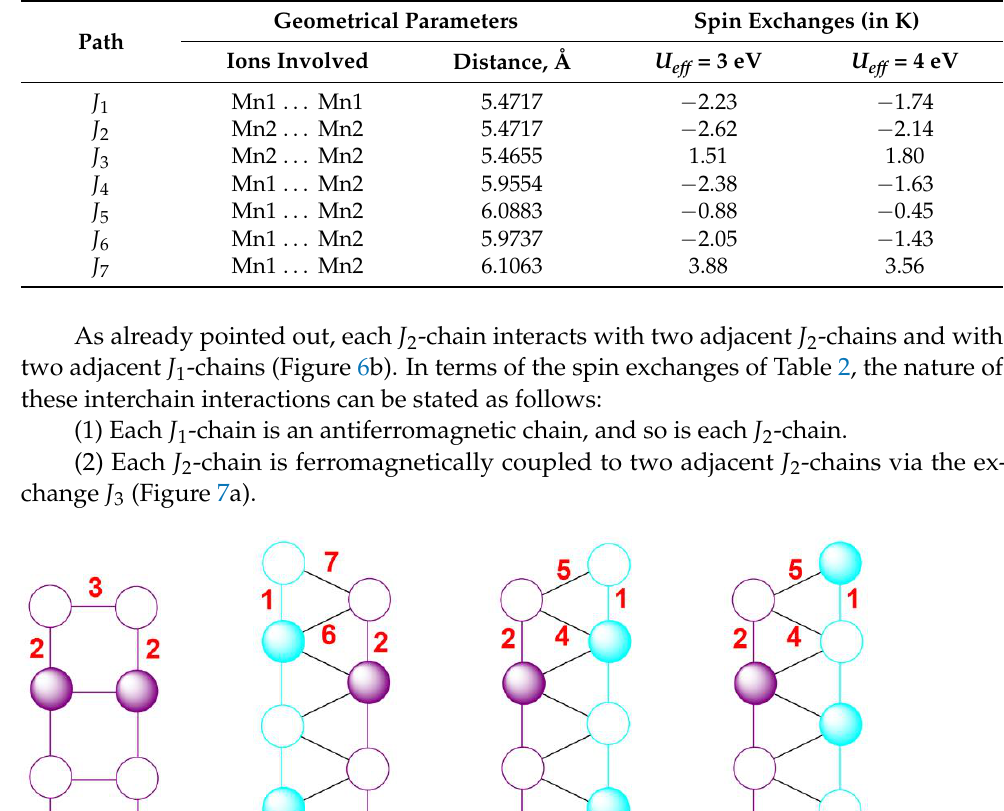
Table 2. Geometrical parameters of the exchange paths and the values of the spin exchanges in Ba 2 Mn 3 (SeO 3 ) 6 . The plus and minus signs of the spin exchanges represent ferromagnetic and antiferromagnetic couplings, respectively. Geometrical Parameters Spin Exchanges (in K) Path Ions Involved Distance, Å